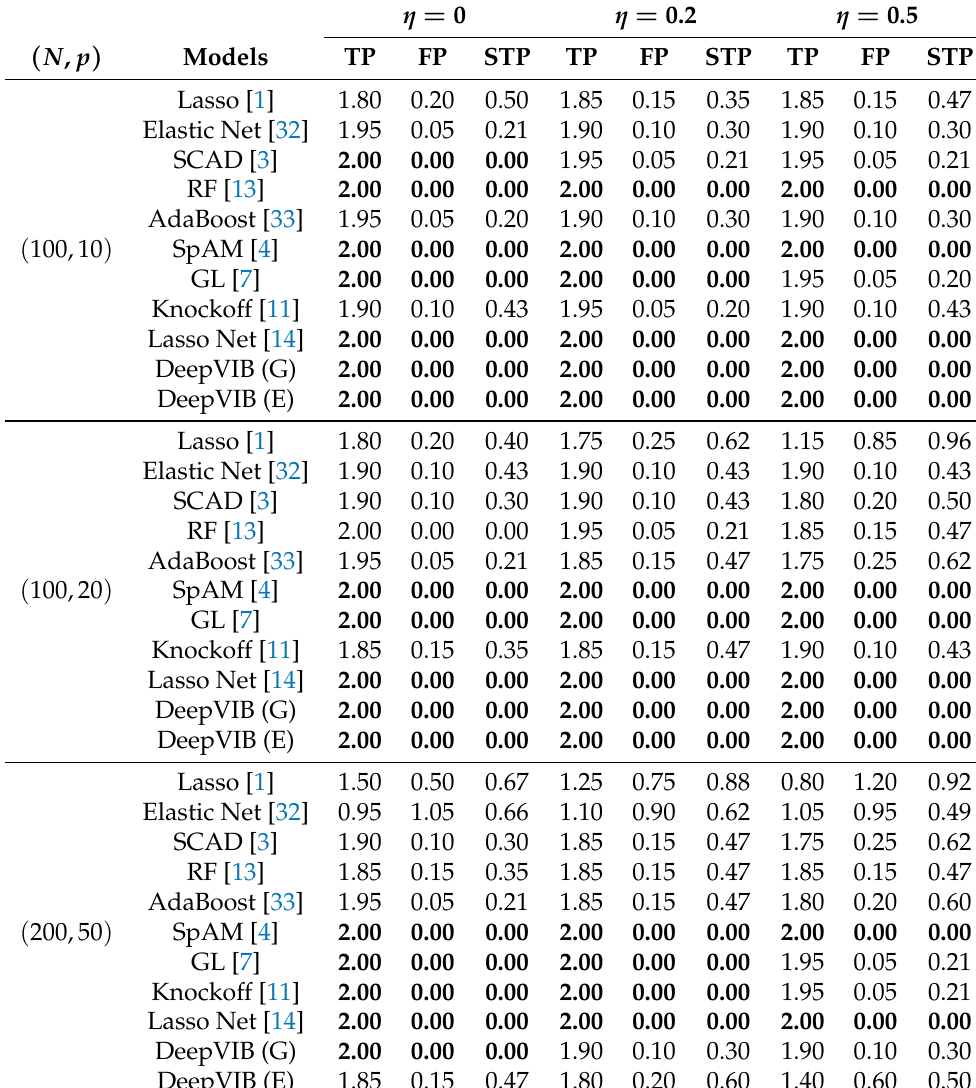
Table 4. The averaged performance of variable selection (Example